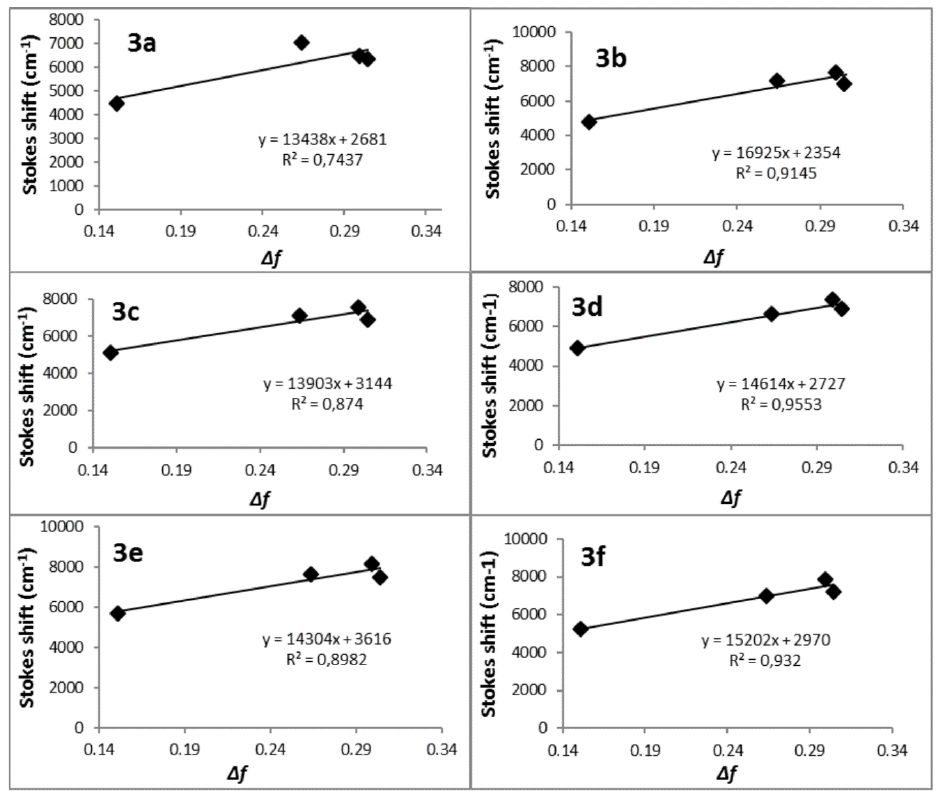
Figure 6. Plots of the Stokes shifts as a function of the solvent polarity parameter Δf (ε, n 2 ) for compounds 3a – f . Table 4. The Onsager cavity radii, slopes, and changes of the dipole moments of compounds 3a – f .